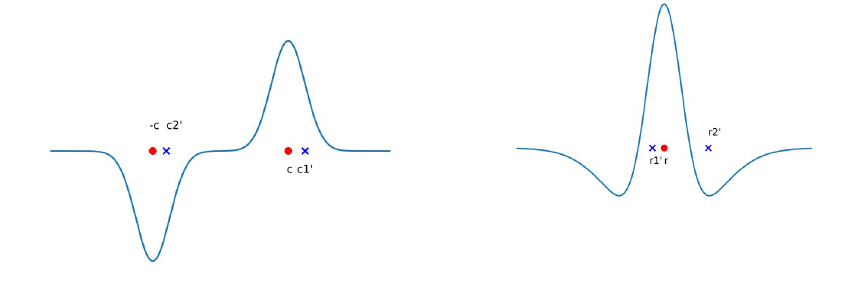
Fig 4. f and g functions, displayed on a 1D axis for illustration purpose. The influence of c 0 and r 0 over c and r , respectively, depends on their position relative to ( c , − c ) and r . In color space, it is positive when c 0 is closer to c , negative when it is closer to − c ; in physical space, it is positive when r 0 is an adjacent neighbor of r , and negative when it is a remote one.